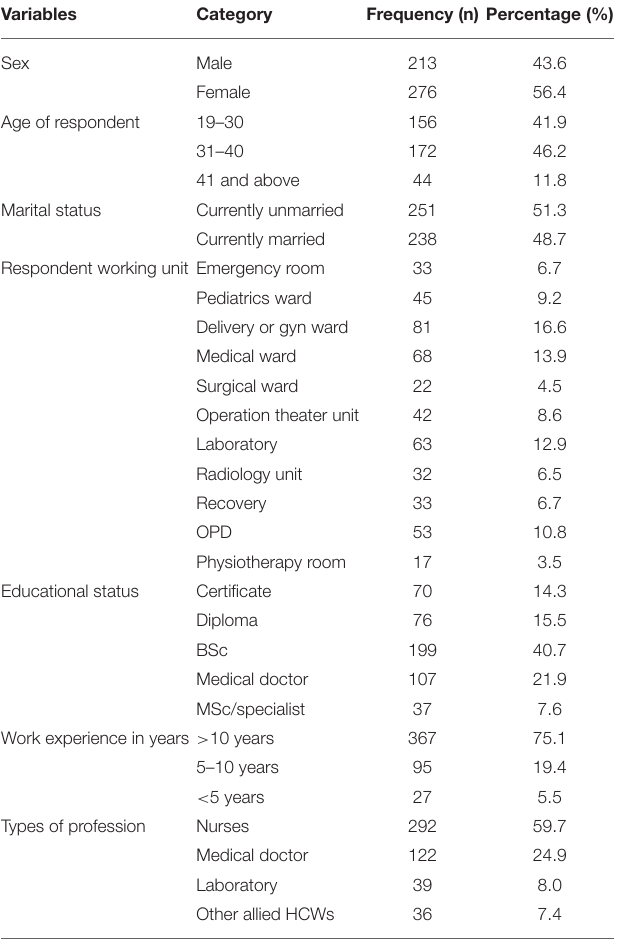
TABLE 4 | Proportion of HCW compliance with PPE utilization by professionals in public hospitals of South Wollo Zone, Northeastern Ethiopia,